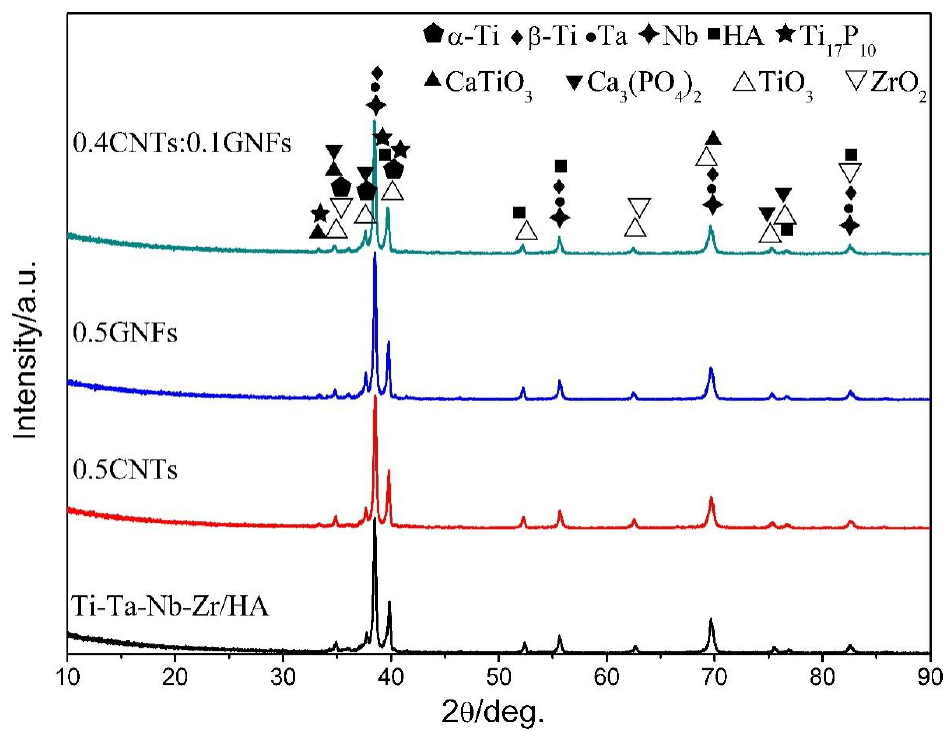
Figure 4. X-ray diffraction patterns (XRD) of nanocomposites sintered at 1000 °C.